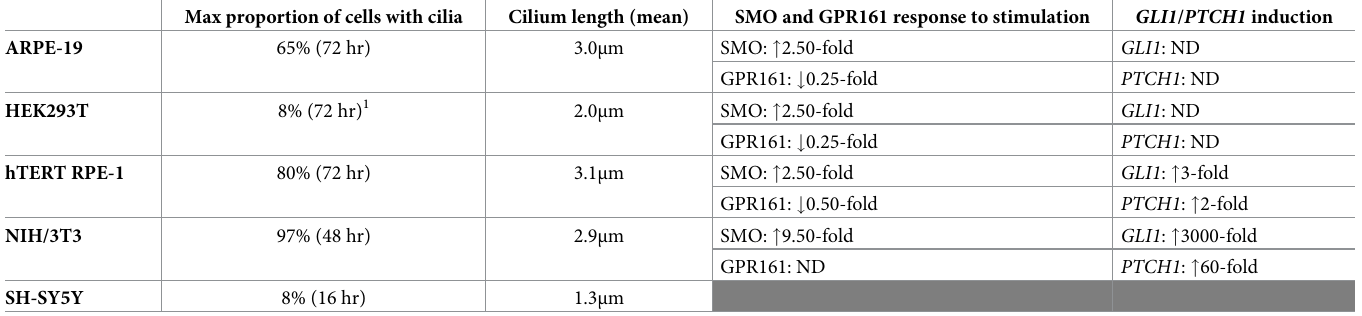
Table 3. Overview of